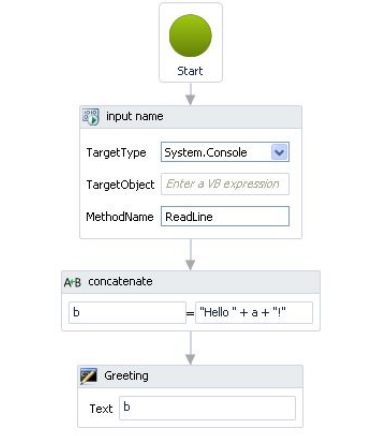
Figure 3: Sample WF